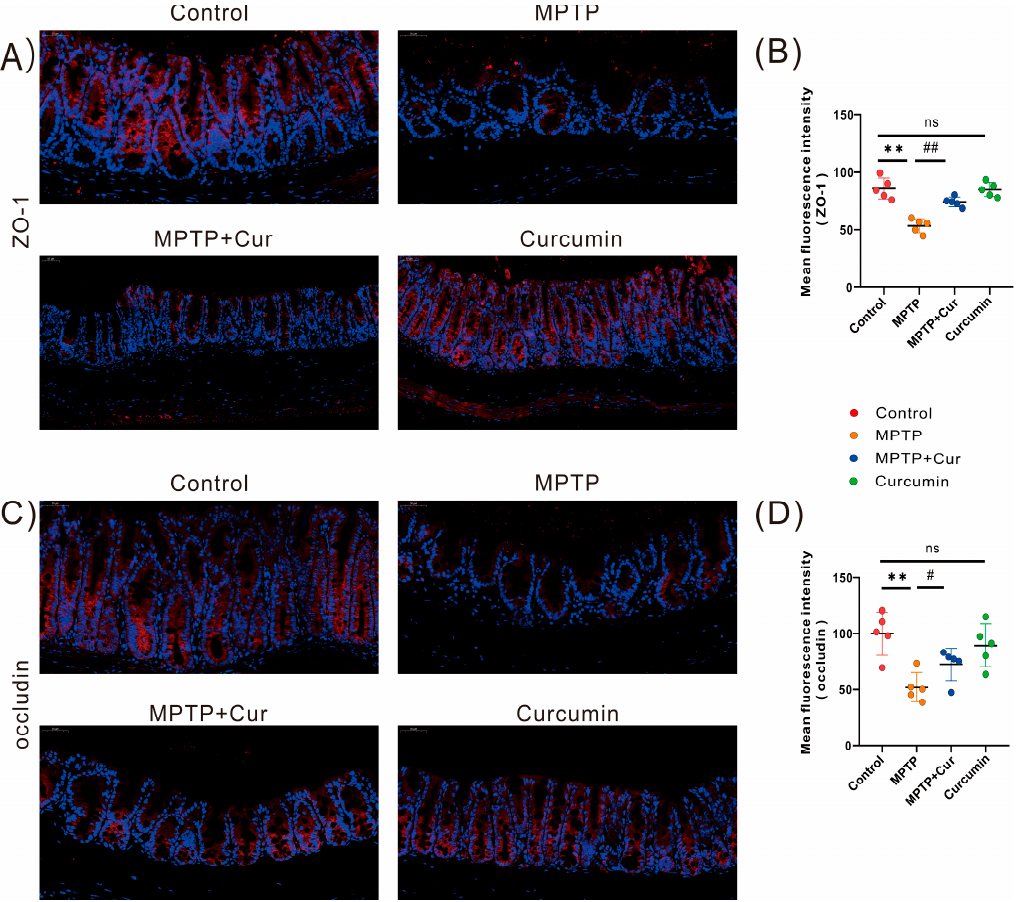
Figure 4. Curcumin treatment ameliorated MPTP-induced gastrointestinal barrier disruption in PD mice. ( A , C ) representative immunofluorescence images of ZO-1- and occludin-positive cells in the cecum. ( B , D ) Analysis of ZO-1 and occludin fluorescence intensity in the cecum ( n = 5);The quantitative analysis of ZO-1- and occludin-positive regions was performed using ImageJ. All statistical differences were tested using the t -test. Data are expressed as the mean ± SEM ( n = 5/group). Representative results are for one of the independent experiments.** p < 0.01 vs. control group. # p < 0.05 and ## p < 0.01 vs. MPTP group. n.s., not significant.